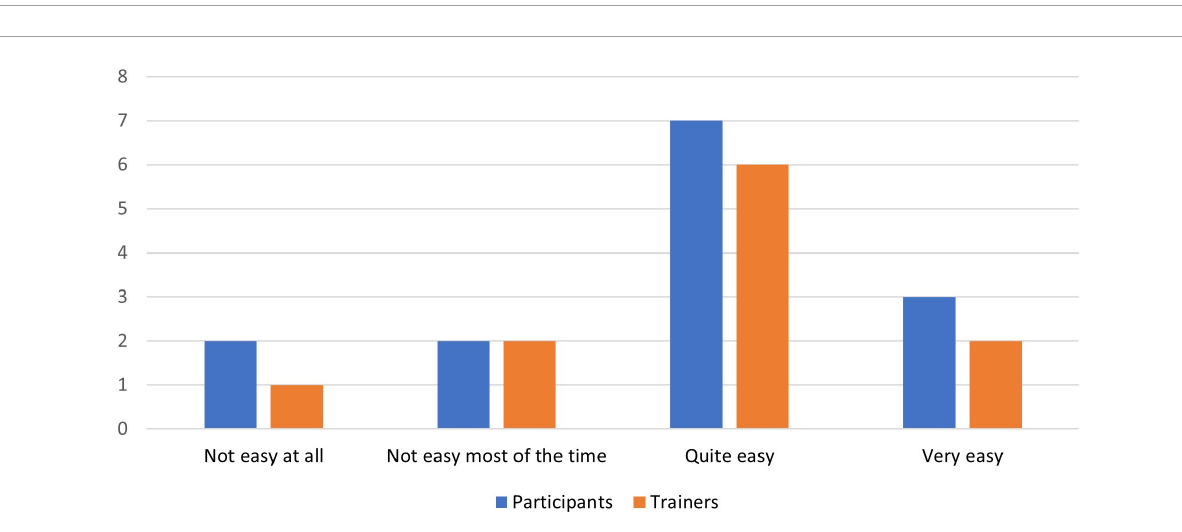
FIGURE5 Feedback on the ease of use of the Augmented Reality Games to Enhance Vocational Ability of Patients (REAP) augmented reality games.